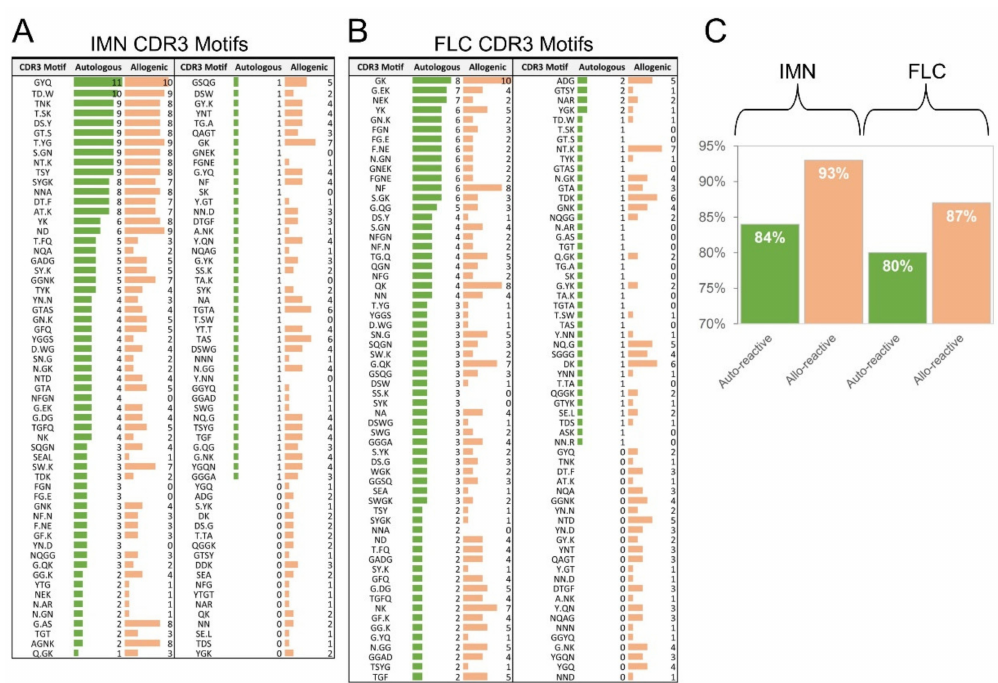
Figure 7. CDR3 motif analysis between auto-reactive and allo-reactive TCRs. ( A ) IMN and ( B ) FLC CDR3 loops found by motif searching. ( C ) Total percentage of IMN and FLC CDR3 loops found by motif searching. Auto-reactive (green) and allo-reactive (orange) sequences are shown as are the number of sequences encoding the